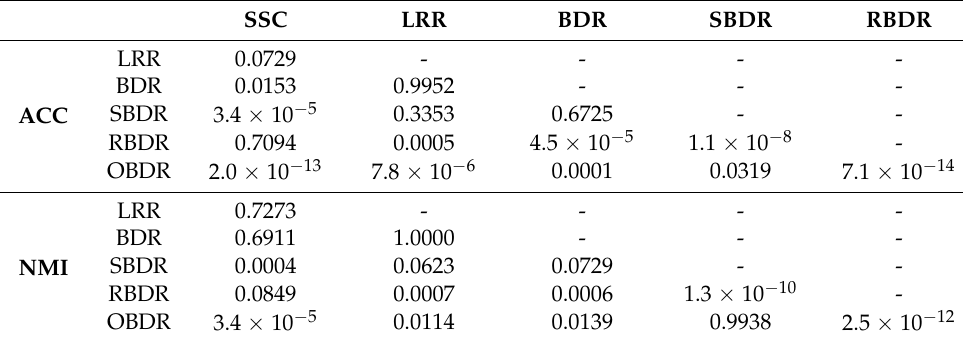
Figure 5. The computational time of algorithms on Dataset1~Dataset4. Figure 5 records the computational time of algorithms on Dataset1~Dataset4 with